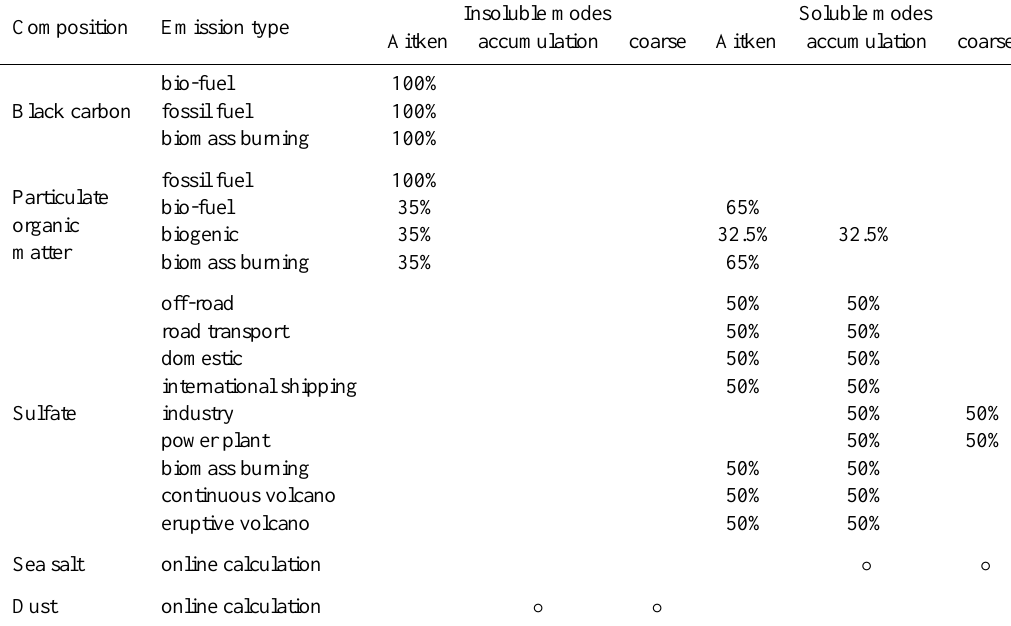
Table 4. Partitioning of the aerosol emissions among different modes. The small circles in the last two rows denote online calculation. Insoluble modes Soluble modes Composition Emission type Aitken accumulation coarse Aitken accumulation coarse bio-fuel 100% Black carbon fossil fuel